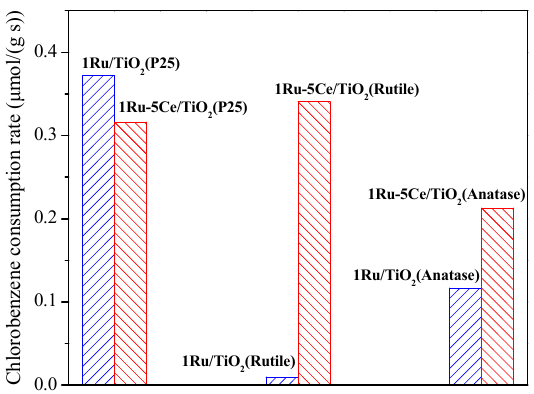
Figure 3. Chlorobenzene consumption rates for 1Ru/TiO 2 and 1Ru ‐ 5Ce/TiO 2 catalysts at 280 °C.